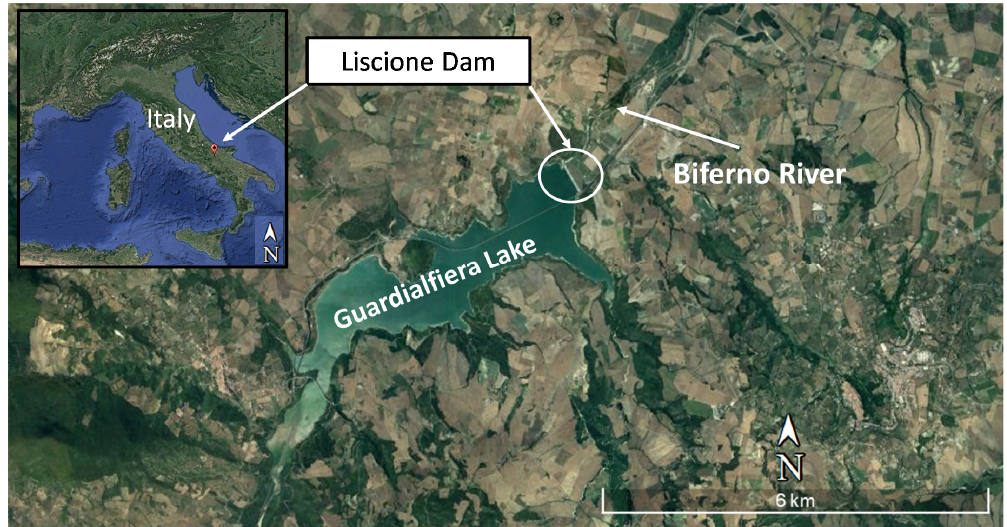
Figure 1. The area investigated: geographical framework [Map data: Google].